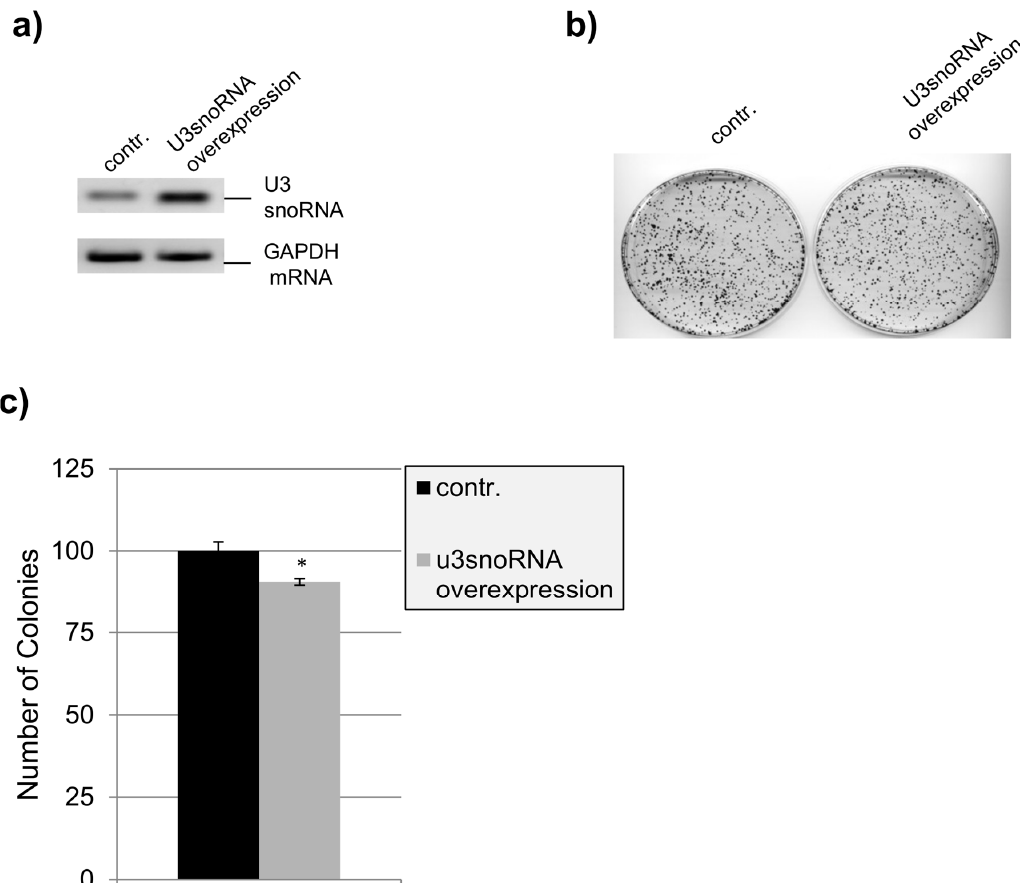
Figure 6. HeLa cell proliferation after external expression of U3snoRNA. Cells were transfected with the U3snoRNA expression plasmid (pcDNAU3) or the empty vector (pcDNA3.1( − )), and were harvested 48 h thereafter. ( a ) Demonstration of U3snoRNA overexpression by reverse transcription polymerase chain reaction (RT ‐ PCR). GAPDH mRNA served as a loading control; ( b ) An overview of the outcome of a colony forming assay performed with control cells and HeLa cells overproducing U3snoRNA; ( c ) Quantitative analysis of the colony forming assay (mean ± SD; n = 3; * p value < 0.05).